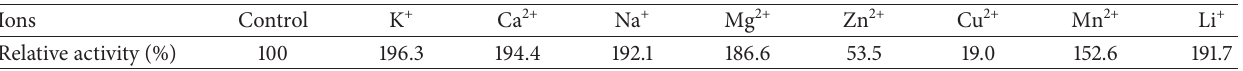
Table 2: Influence of metal ions on xanthan lyase activity. The assays were performed at 40 ∘ C and pH 6.5 and the residual enzyme activity was expressed as the percentage against a control without metal ion addition.